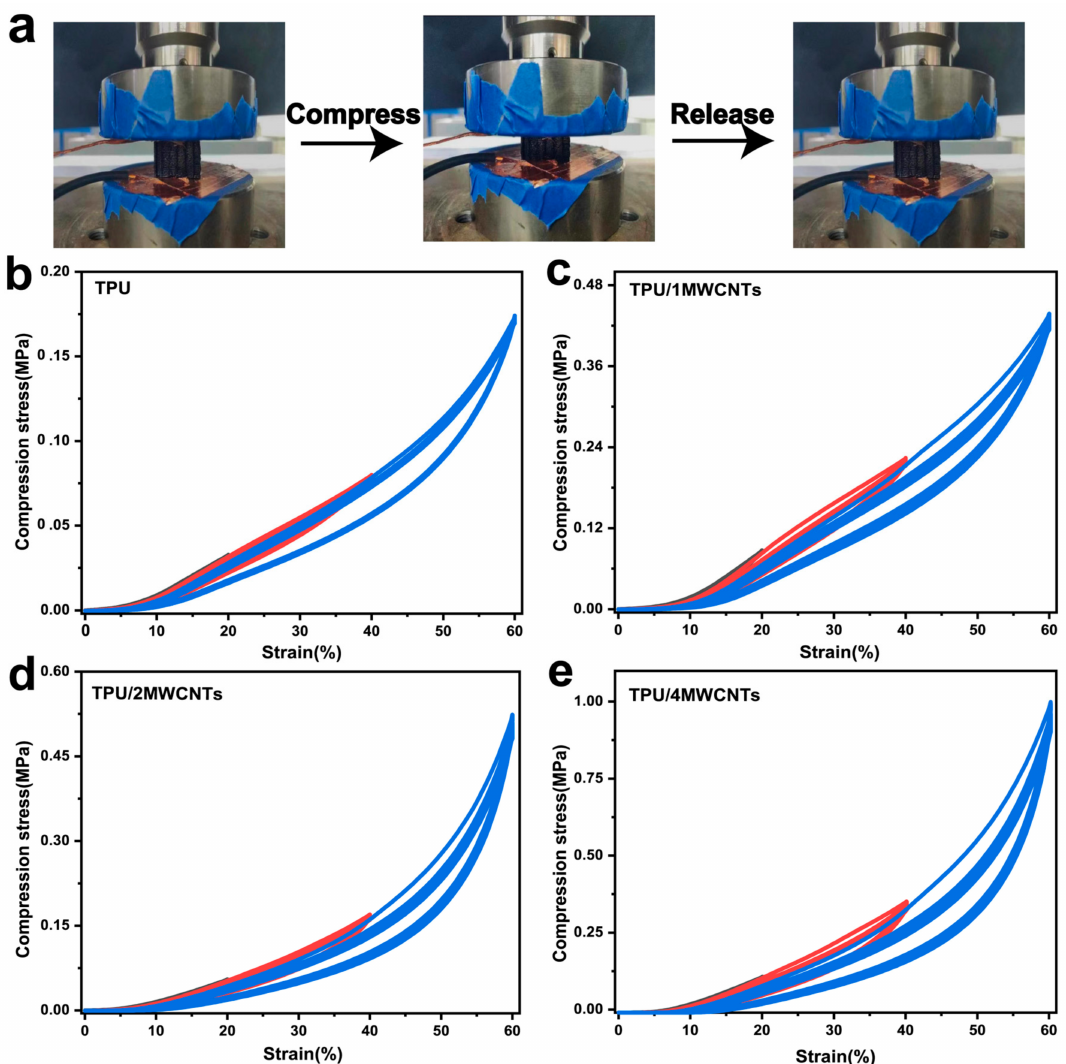
Figure 4. ( a ) The loading and releasing stages of the compression process; and ( b – e ) dynamic cyclic compression stress-strain curves of TPU foam and TPU/MWCNTs composite conductive foam with different MWCNTs contents (0, 1, 2, 4 wt%).